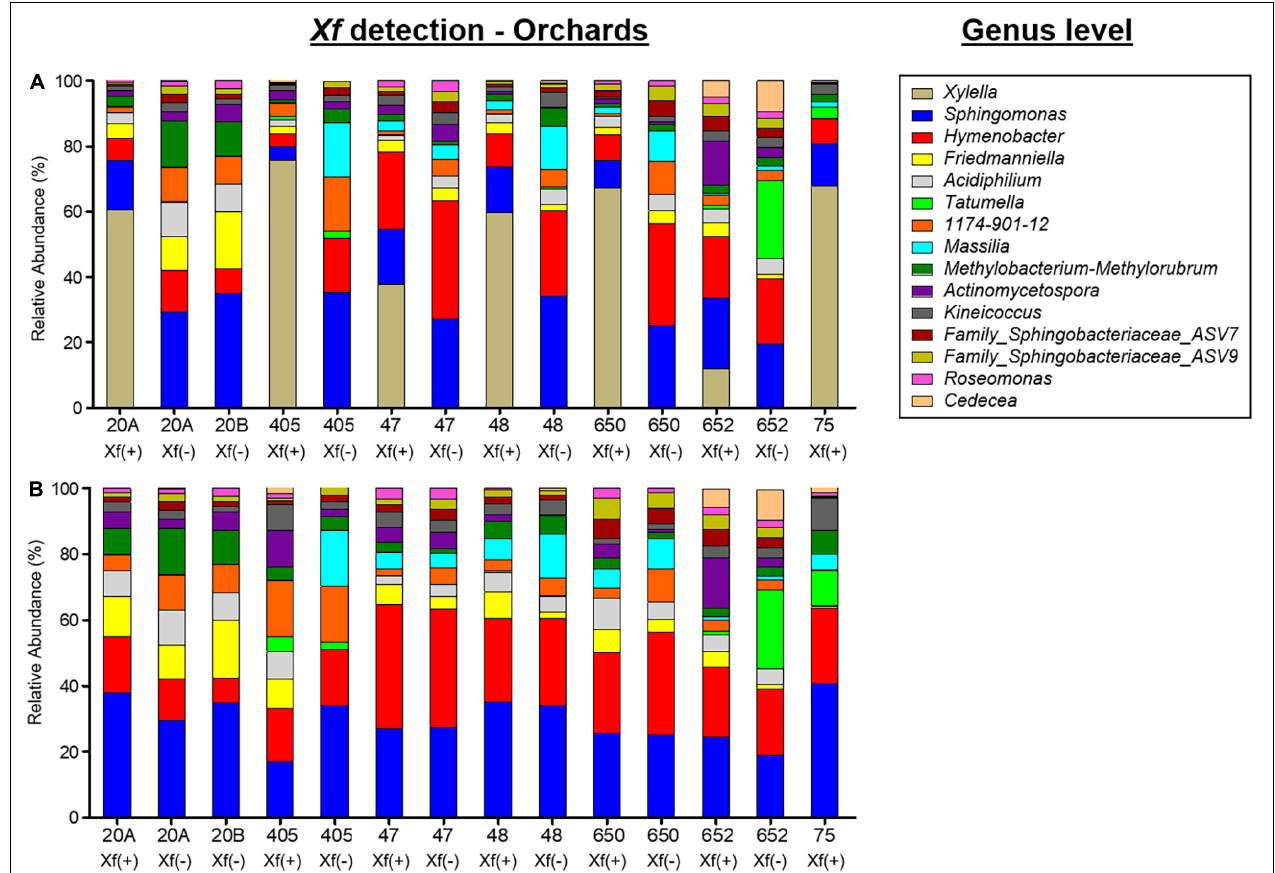
FIGURE 5 | Bar plots showing the relative abundance of bacterial taxa at the genus level in the xylem of almond trees sampled in different orchards in Alicante province before (A) or after (B) the removal of Xylella fastidiosa ASVs from the data set. X. fastidiosa (+) and X. fastidiosa (–) refer to X. fastidiosa -infected or non-infected almond trees, respectively.